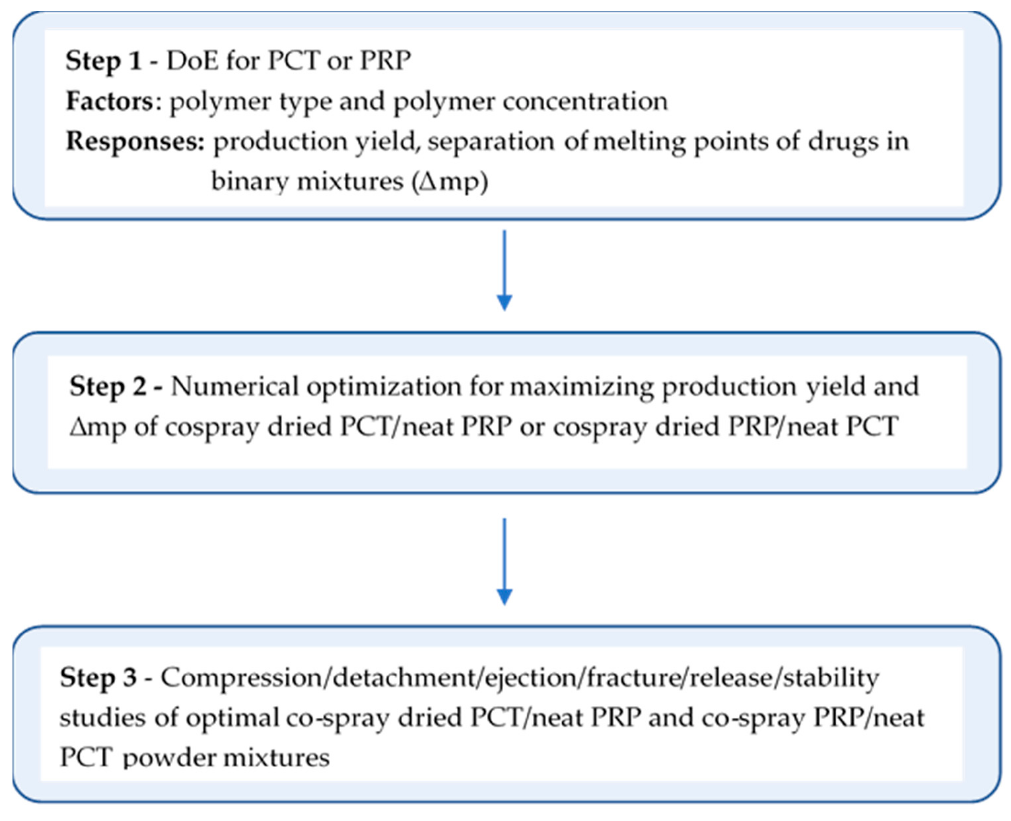
Figure 2. Flow chart of work progress.